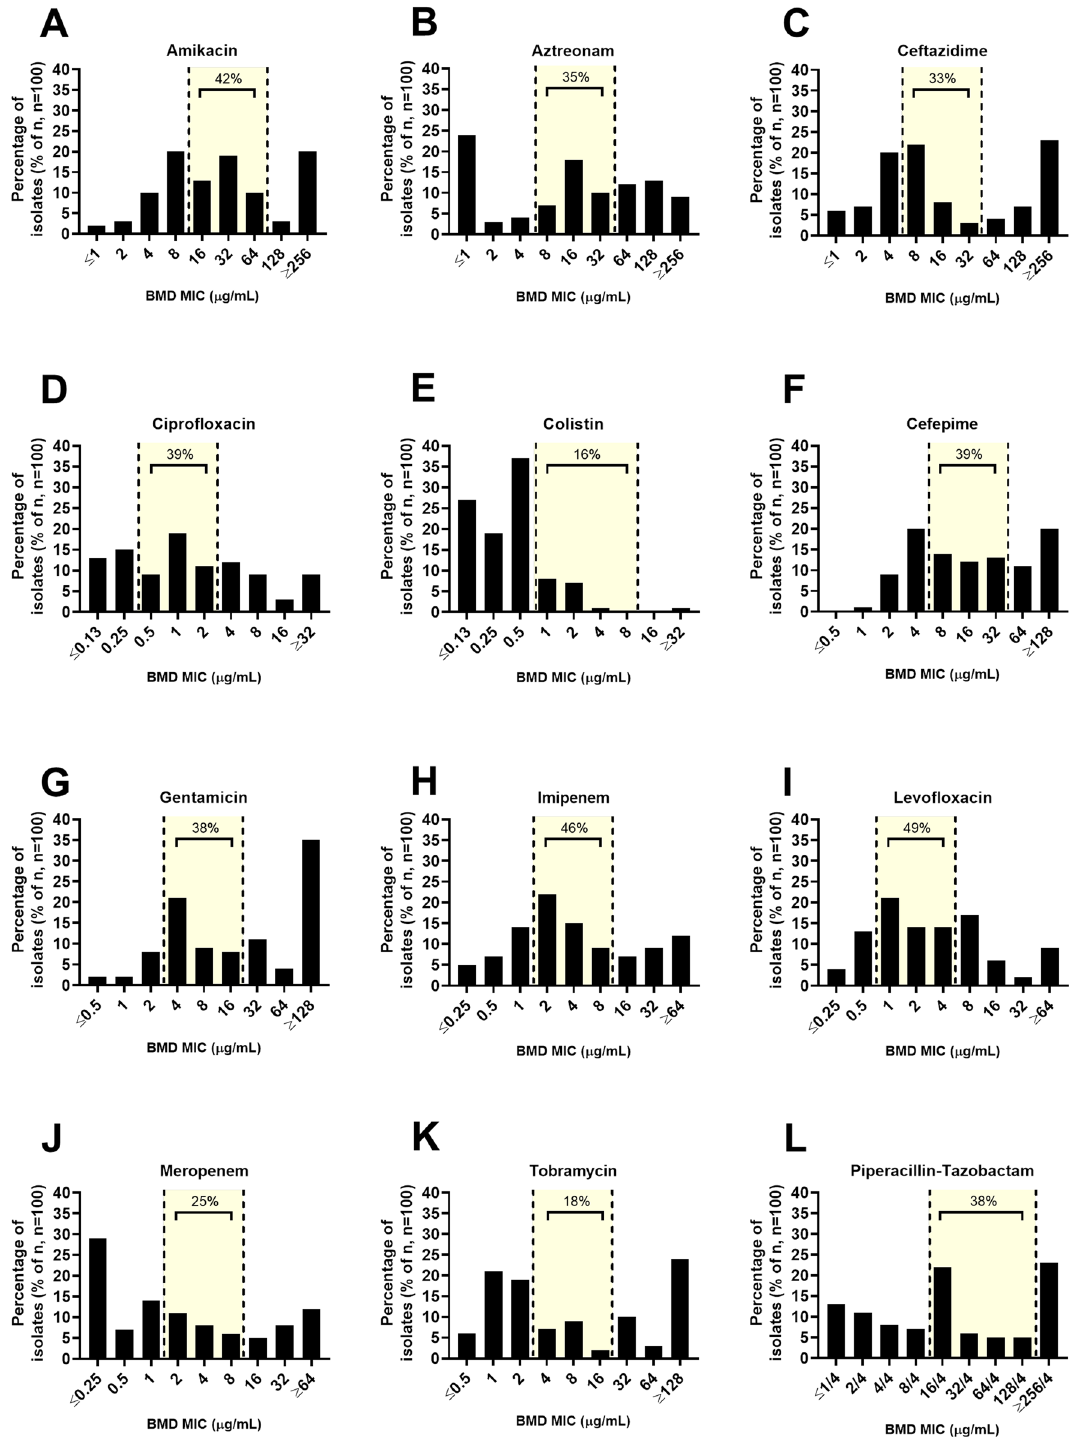
Figure 2. Distribution of MICs for the 100 P. aeruginosa isolates. The frequencies of different MICs for each of the antimicrobials tested were tabulated as a percentage of isolates (%) with a particular MIC value (µg/mL) as measured by rBMD for: ( A ) amikacin, ( B ) aztreonam, ( C ) ceftazidime, ( D ) ciprofloxacin, ( E ) colistin, ( F ) cefepime, ( G ) gentamicin, ( H ) imipenem, ( I ) levofloxacin, ( J ) meropenem, ( K ) tobramycin, ( L ) piperacillin- tazobactam. Yellow shading indicates the 2020 CLSI rBMD interpretive range for each of the antibiotics. Hatched borders indicate the lower and upper distinctions for MIC interpretation, where isolates were deemed susceptible (lowest concentration and below), intermediate (middle concentration) or resistant (highest concentration or